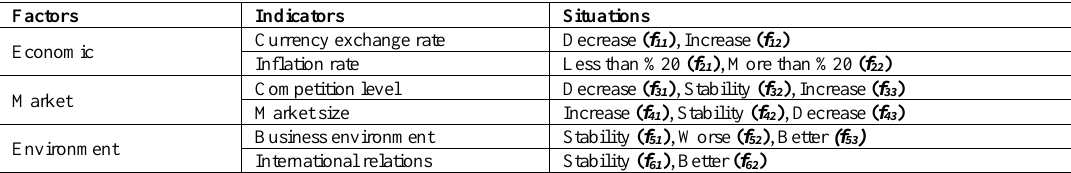
Table 2. Factors and different states of